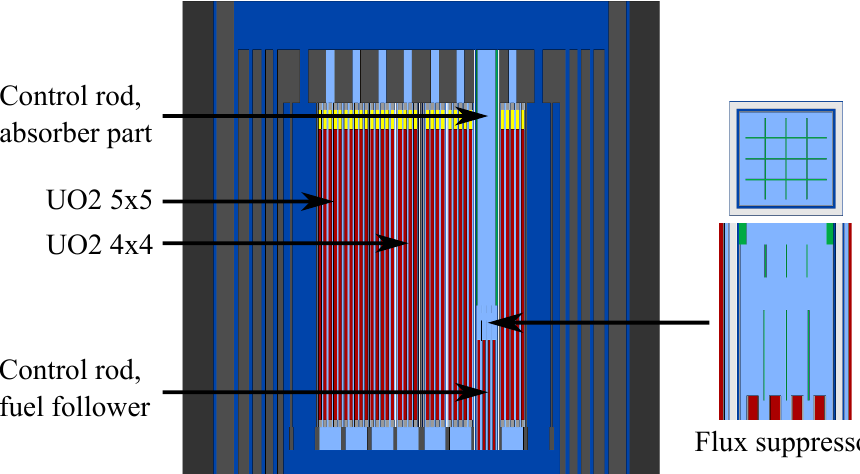
material 1 . 35 wt. % 10 B in type SS304 stainless steel ( 1 . 35 wt. % 10 B / SS304). The lower section is a fuel follower with a 4 × 4 fuel rod lattice. The middle section contains a flux suppressor with two groups of six small absorber plates each. These plates also consist of 1 . 35 wt. % 10 B / SS304 and are arranged in a rectangular grid. The CRs are surrounded by square guide tubes made from Zircaloy-2.